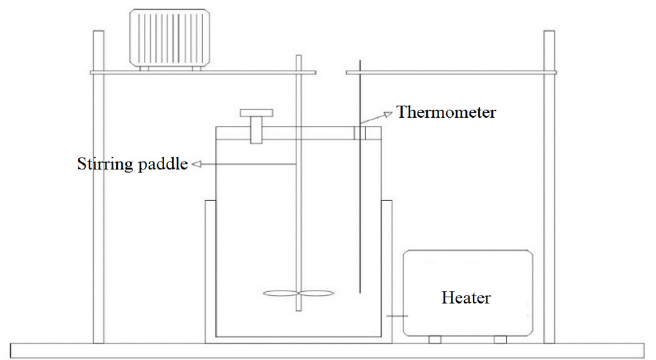
Table 3. Main physical and chemical properties of WCO.